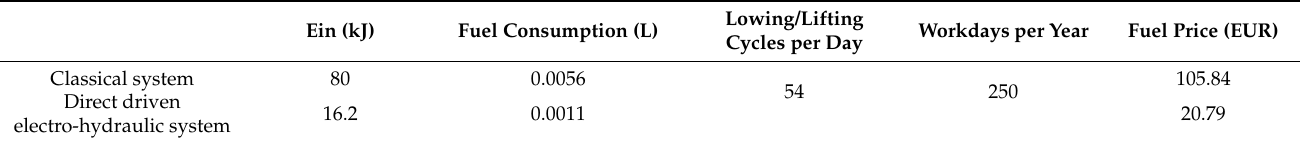
Figure 1. Skidder EcoTrac 120 V in operation. Table 1. System fuel consumption.